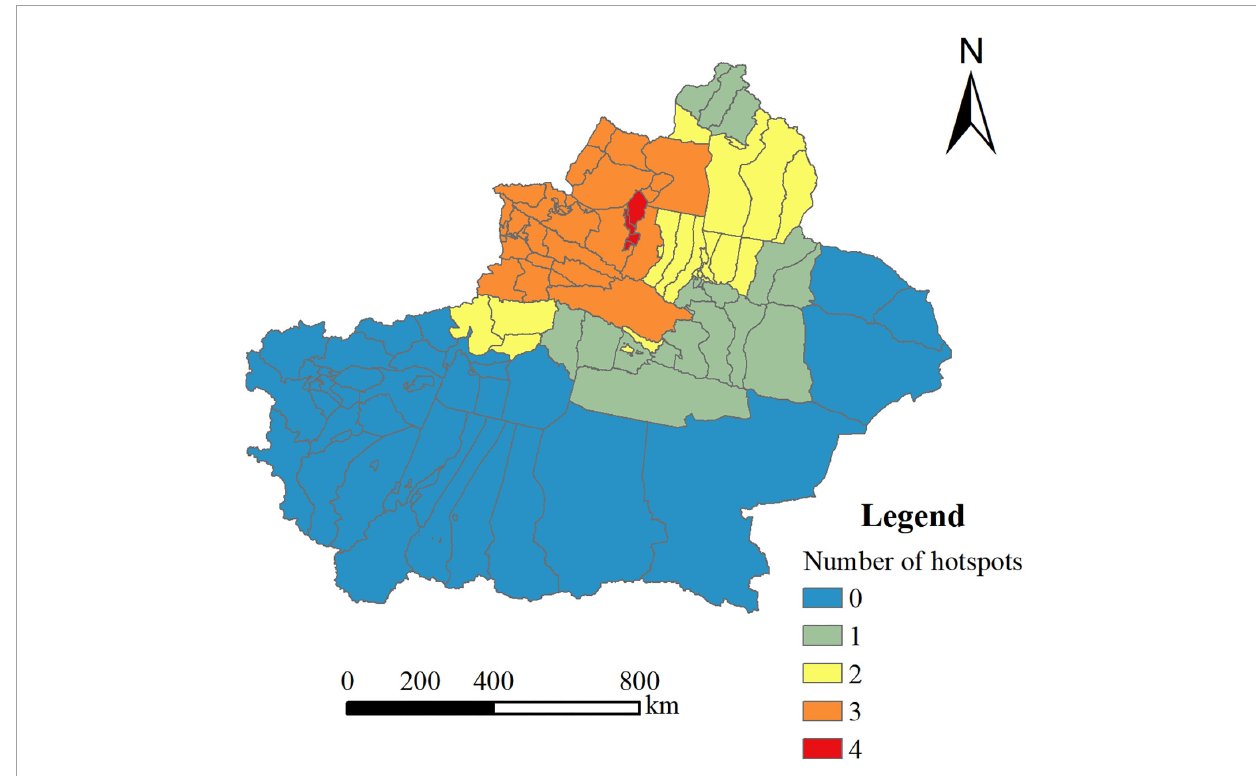
FIGURE4 Concurrence of the four ecosystem service hotspots.